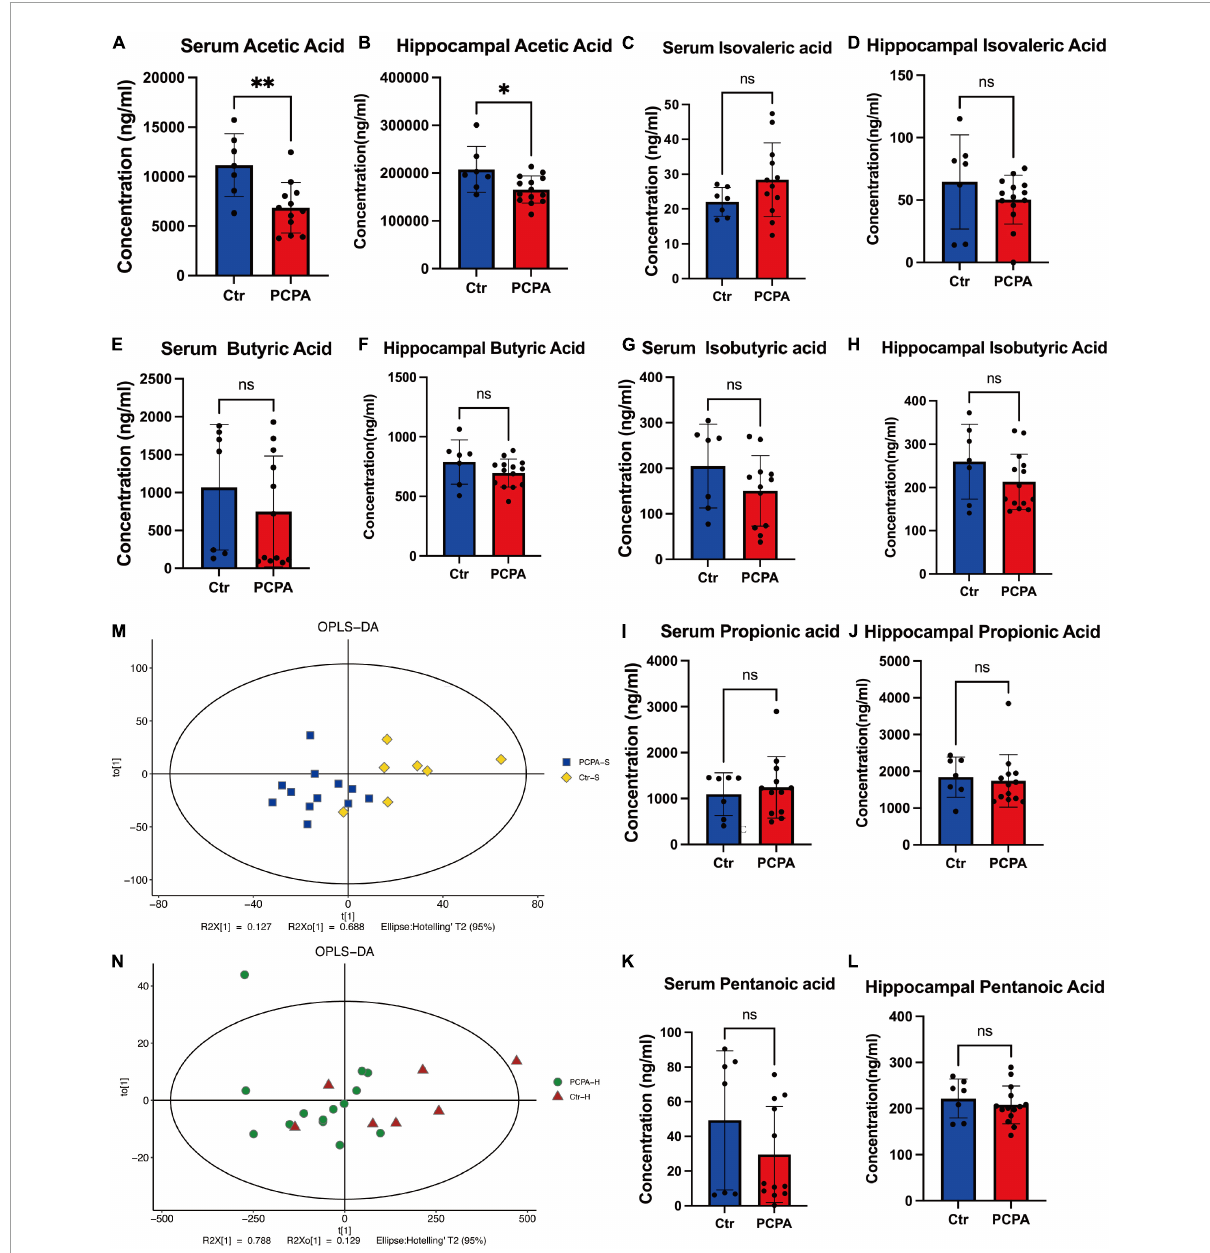
FIGURE3 The levels of short-chain fatty acids (SCFAs) in the blood and hippocampus. (A–L) Comparison of the SCFA levels in the hippocampus and the blood between two groups. (M,N) OPLS-DA plot. Data are presented as the mean ± SEM. ∗ P < 0.05; ∗∗ P < 0.01; ns, not significant.